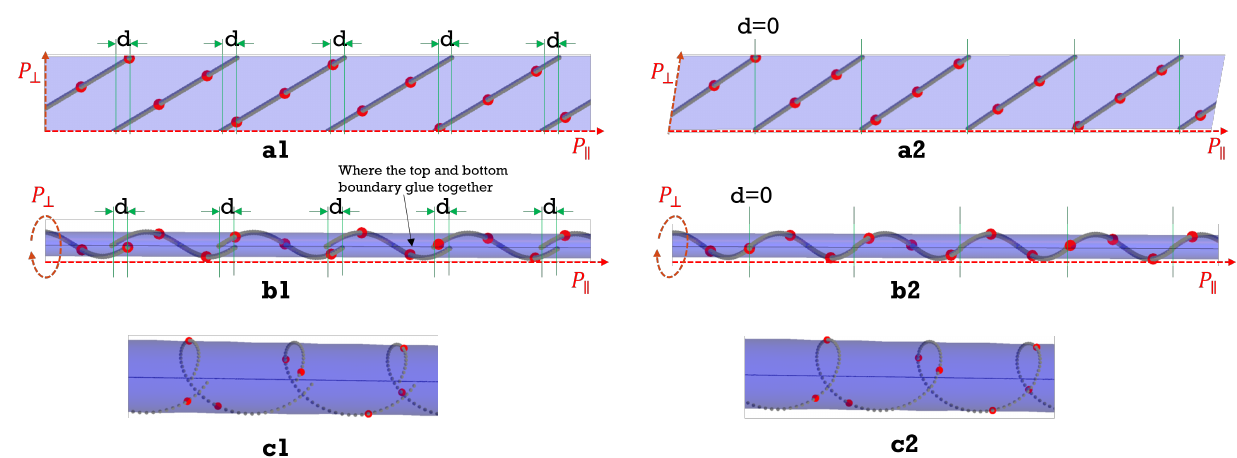
Figure 4. Cut region ( a1 ) wrapped into a cylinder ( b1 ), with an exaggerated view to better see mismatch ( c1 ). When introducing shear, cut region ( a2 ) becomes a parallelogram and mismatches in cylinder close to form a true helix Figure 4. The cut region (a1) wrapped into a cylinder (b1), with an exaggerated view to better see ( b2 , c2 ). the mismatch (c1). When introducing shear, the cut region (a2) becomes a parallelogram and the mismatches in the cylinder close to form a true helix (b2), (c2).